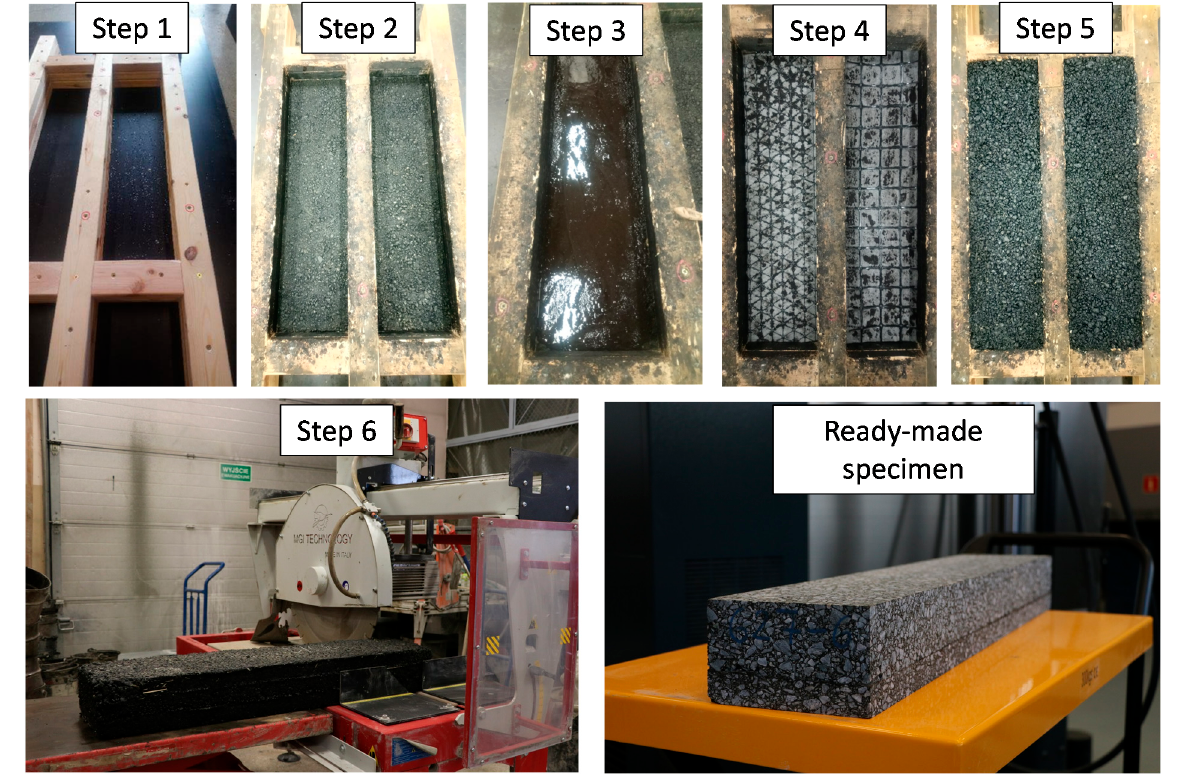
Figure 3. View of the successive steps of specimen fabrication. Step 1 – completely assembled wooden mould. Step 2 – compacted lower layer AC 11 W. Step 3 – application of bitumen emulsion C 69 B3 PU. Step 4 – application of geogrid